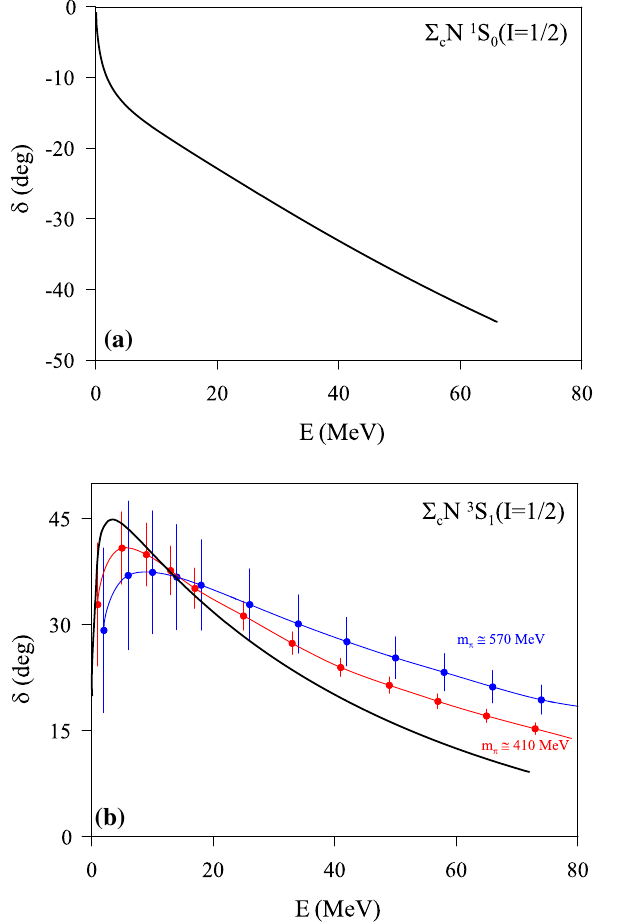
Fig. 5 a Phase shifts for the (cid:3) c N 1 S 0 ( I = 1 / 2 ) partial wave, as a function of the c.m. kinetic energy, predicted by the CQM. b Phase shifts for the (cid:3) c N 3 S 1 ( I = 1 / 2 ) partial wave as a function of the c.m. kinetic energy. The black solid line stands for the prediction of the CQM. The blue (red) filled circles represent the results of the HAL QCD Collaboration [44] at m π = 570 ( 410 ) MeV. The vertical line at eachpointrepresentsthestatisticalerrorofthelatticeQCDsimulations. The solid blue and red lines are just a guide to the eye